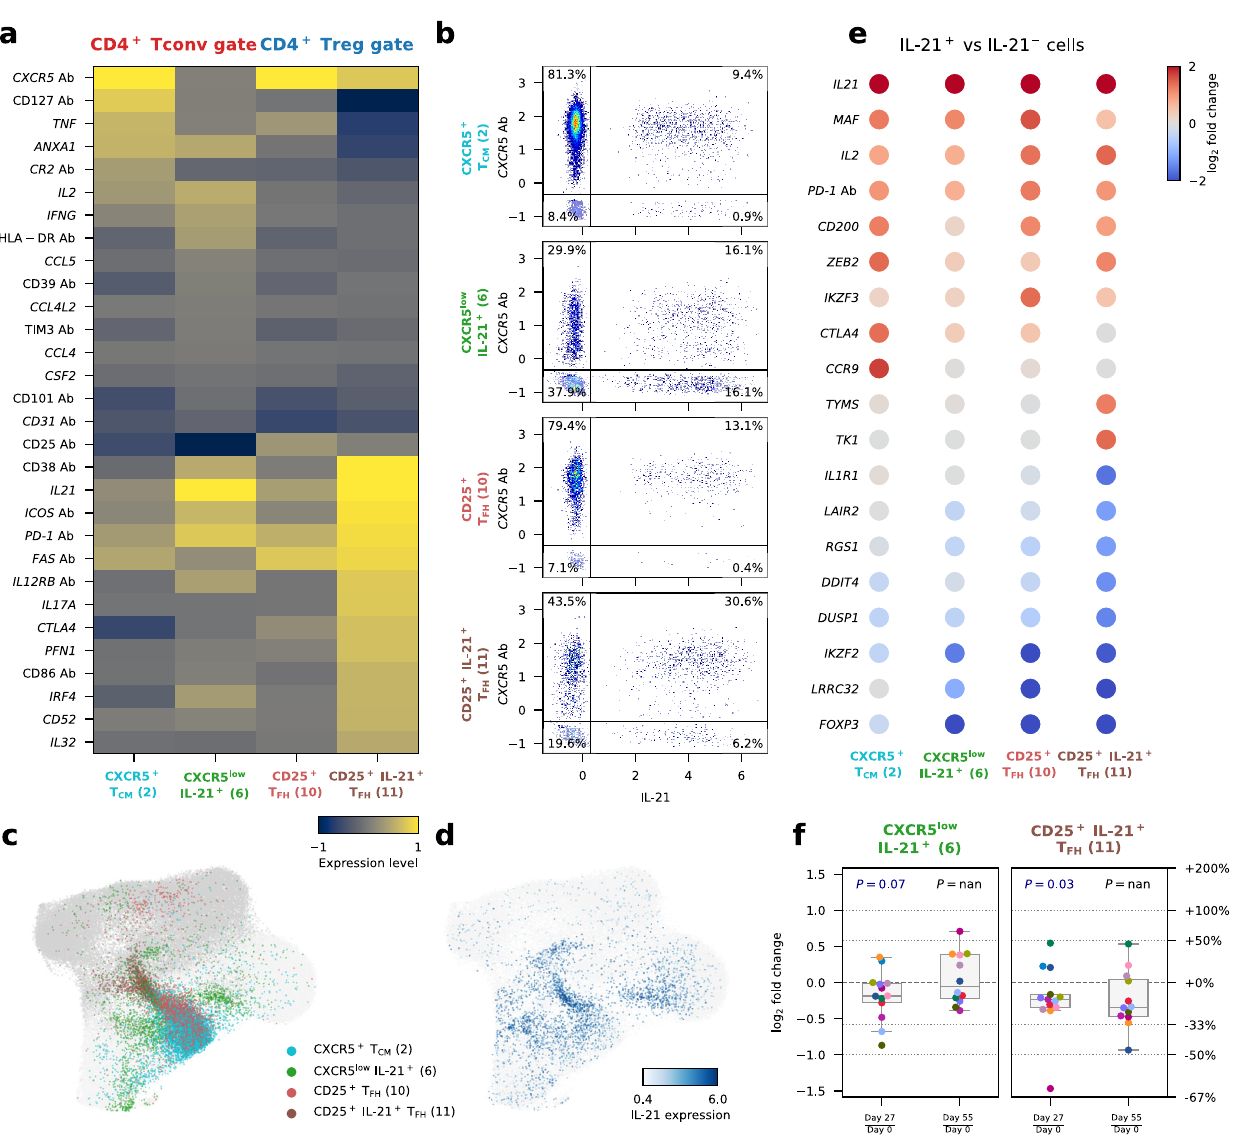
selected.Foldchangeand P valueswerecalculatedusingageneralizedlinearmodel implemented in DESeq2 (see “ Methods ” ). f Relative frequency changes of IL-21 + cellswithinthe two CD4 + Tcellsubsetsdisplaying higherexpressionlevelsof IL-21: the CXCR5 low IL-21 + subset (left panel) and the CD25 + IL-21 + T FH subset (right panel), comparing Day 27 and Day 55 with Day 0, respectively. Each dot represents cells fromasingleparticipant.Dotswiththesamecolourrepresentthesameparticipant. n =13participants. Eachboxranges from the fi rst quartile (Q1)to the third quartile (Q3),withacentrallineindicatingthemedian.Thebottomandtopwhiskersextend to the most extreme data points within Q1 − 1.5×(Q3 − Q1) and Q3+1.5 × (Q3 − Q1), respectively. P values were calculated by comparing the relative frequency values between the two time points using a two-sided Wilcoxon signed-rank test. Source data for ( a , e , f ) are provided as a Source Data fi